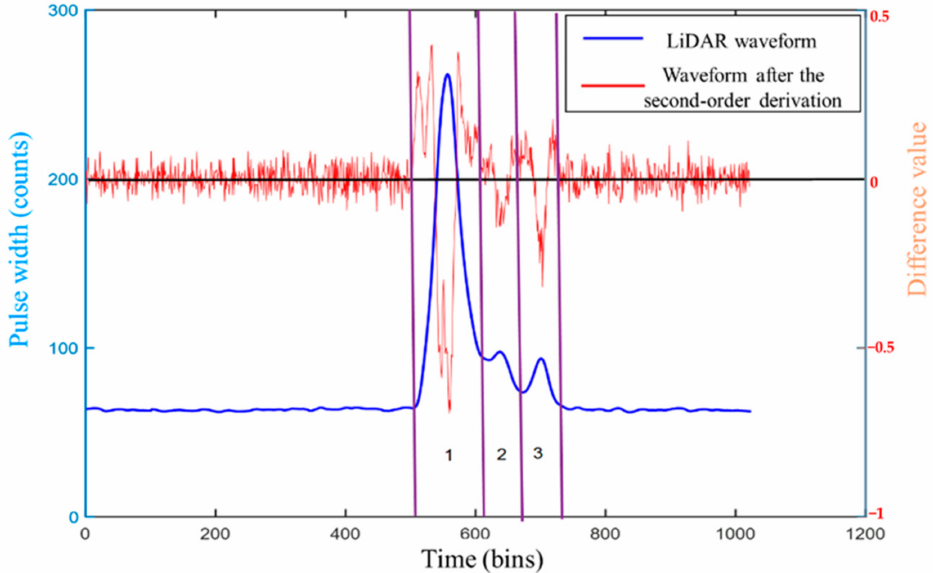
Figure 2. Comparison of the LiDAR waveform and the waveform after the second-order derivation. In Figure 2, the blue line represents the LiDAR waveform, which can be decomposed into three Gaussian components which are the parts 1, 2 and 3, while the red line represents the waveform after the second-order derivation. After putting the LiDAR waveform and the second-order differential waveform into a diagram to find the second-order difference, it can be more significantly observed that each Gaussian component corresponds to a downward “spike”. The intersection of the second-order difference of the waveform and the x -axis is the inflection point of the Gaussian component and each LiDAR echo component corresponds to two inflection points, indicating that two adjacent odd–even inflection points, i.e., x 2 i − 1 and x 2 i , can determine a Gaussian component. When the left and right inflection points of the Gaussian component are zero, the two inflection points are obtained. When the left and the right inflection points of the Gaussian component are zero, the two inflection points are obtained. However, sampling of the LiDAR echo results in the time-series, which is always discrete and, so, it is not always zero. Therefore, when calculating the inflection point of the LiDAR echo (the step length of x is set to 1), the inflection point on the left, x 2 i − 1 , is determined by the adjacent coordinates, x 2 i − 1, left , y 2 i − 1, left and x 2 i − 1, right , y 2 i − 1, right , of the upper and the lower sample points, which after second-order differencing are closest to the x -axis, while x 2 i − 1 matches the nearest inflection point, x 2 i